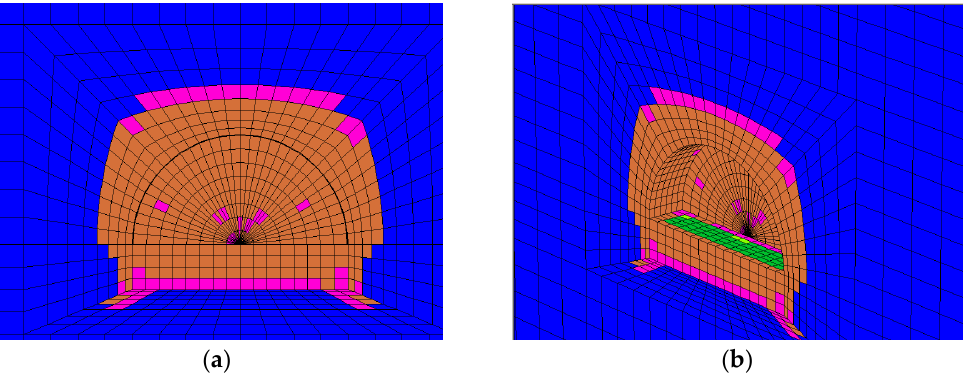
Figure 16. Numerical calculation of loose circle for nonelectronic detonator blasting excavation. ( a ) Plane view; ( b ) 3D view.